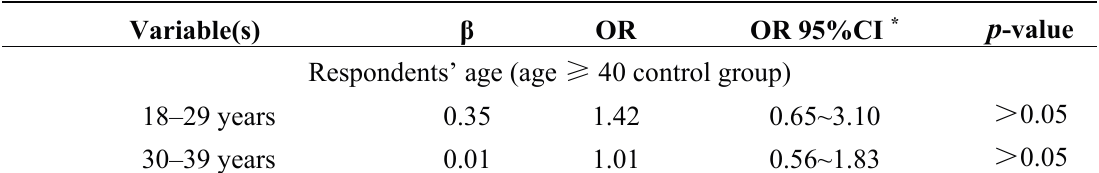
Table 3. Non-conditional multivariate logistic regression analysis for the association between socio-demographic and air pollution knowledge